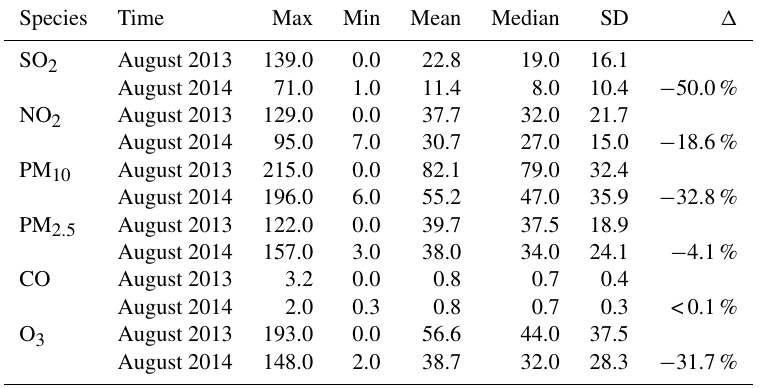
Table 3. Statistical analysis of hourly data in August 2013 and August 2014 at XL station (the unit is µgm − 3 except CO (mgm − 3 )) . The change percentage of species ( (cid:49) ) in August 2014 is based on August